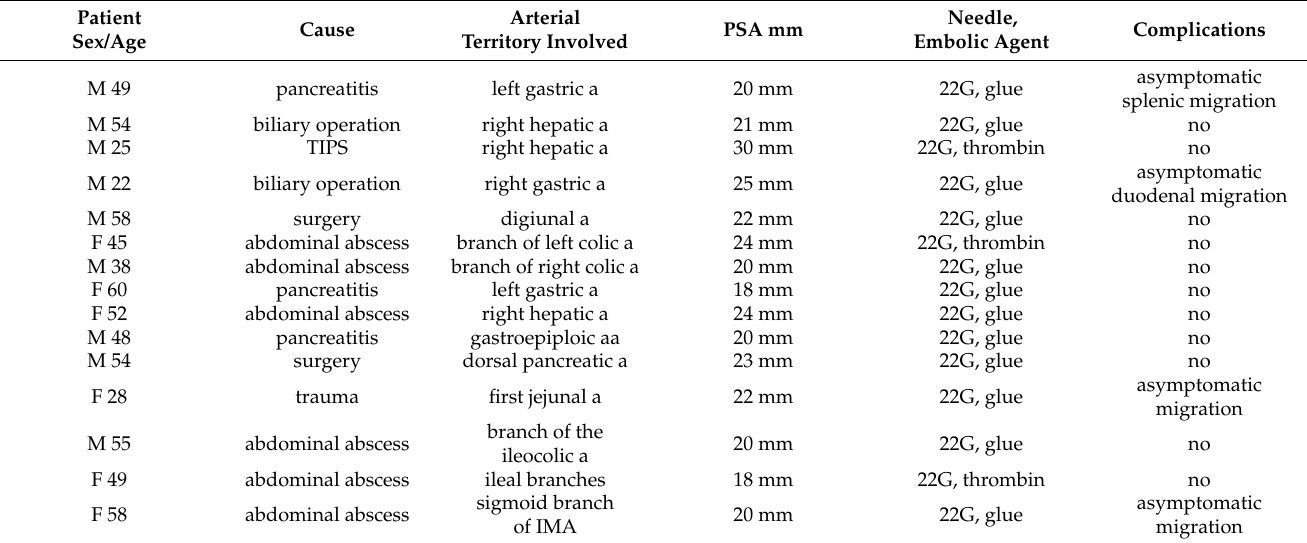
Table 1. Clinical data of patients with PSA embolized with percutaneous